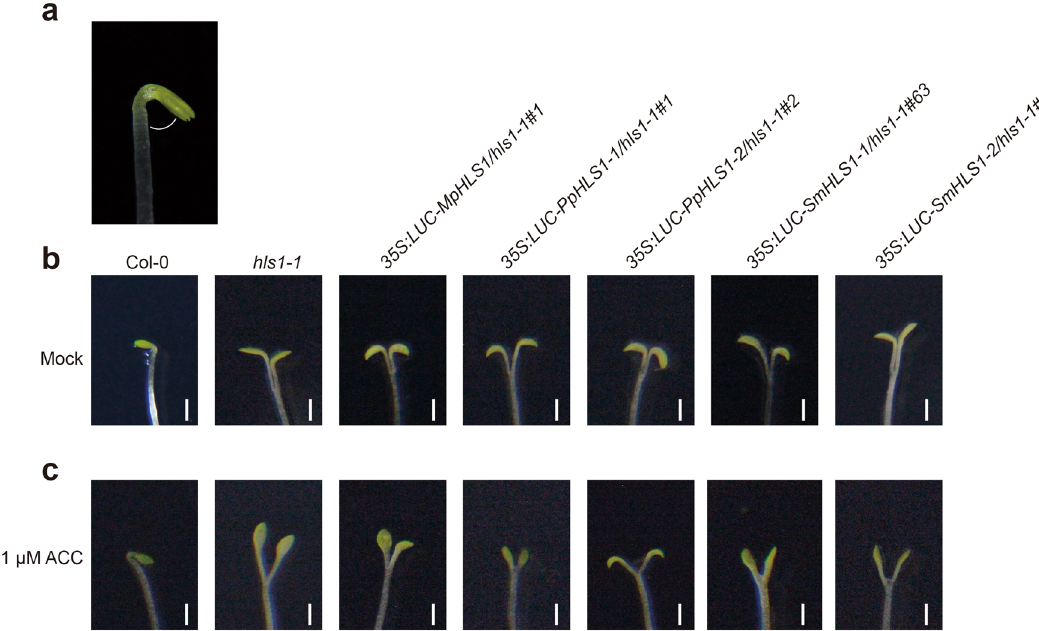
Fig. 8 Hook angle phenotypes in complementation lines. a Illustration of the hook angle position in 4-day-old etiolated Col-0 seedling grown on MS medium. b Representative images showing hook angles in 4-day-old etiolated seedlings grown on MS medium. c Representative images showing hook